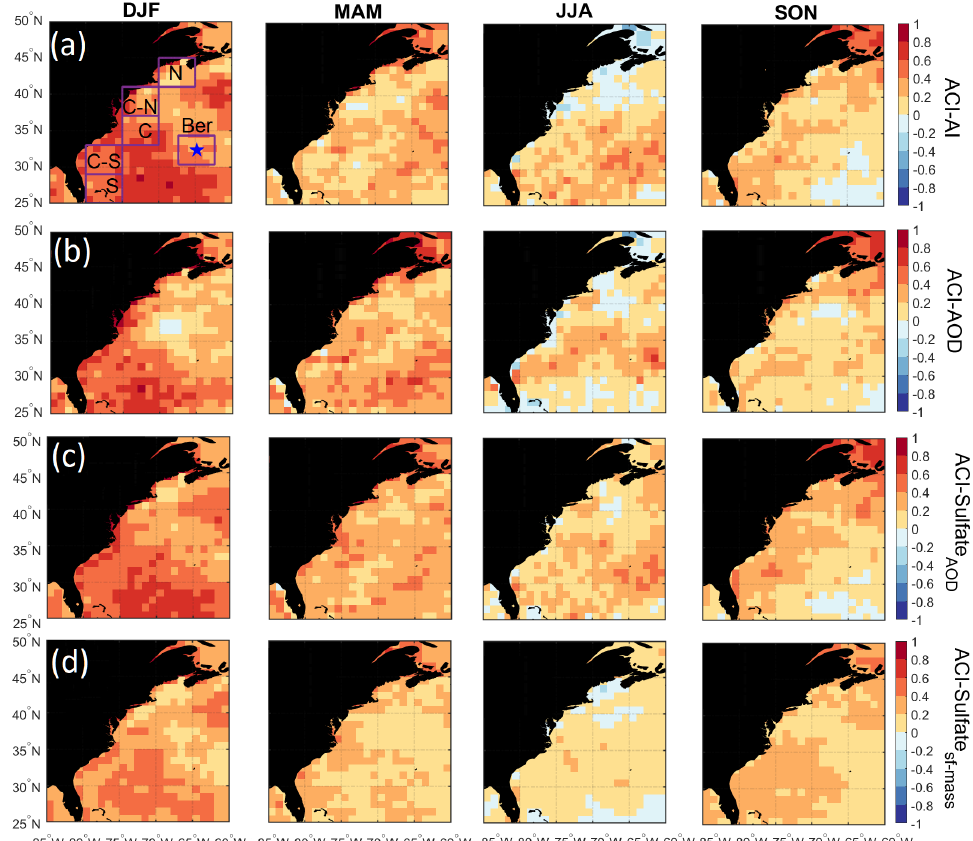
Figure 7. Seasonal maps of the aerosol–cloud interaction (ACI) parameters over the WNAO using daily N d and four different aerosol proxy parameters (AI, AOD, Sulfate AOD , Sulfate sf-mass ) from CERES-MODIS and MERRA-2, respectively. ACI statistics associated with the six sub-domains shown are summarized in Table